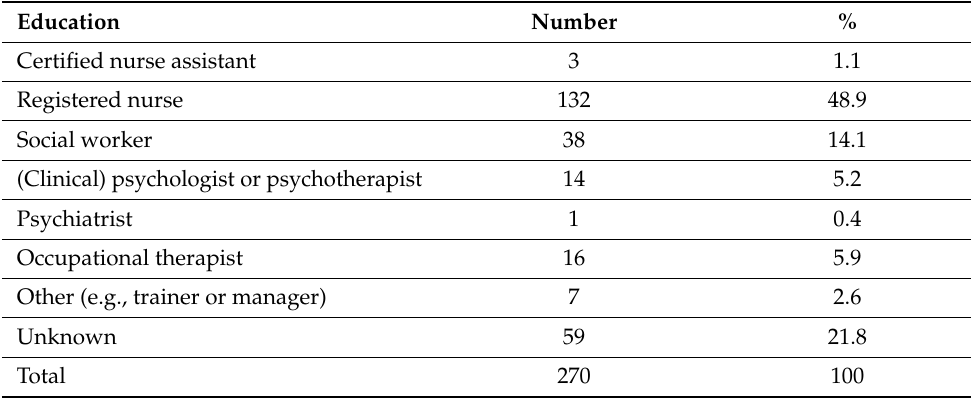
Table 2. Professional backgrounds of the